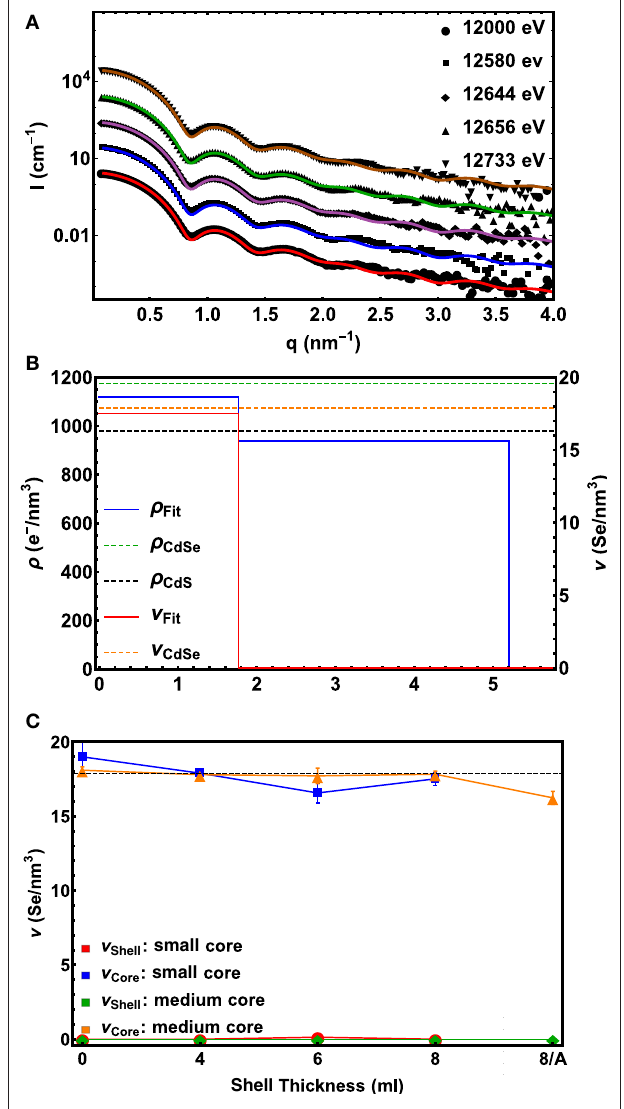
FIGURE 2 | (A) Experimental ASAXS curves (symbols) fitted with a unique spherical core/shell model (lines) for the small core/shell CdSe/CdS NC-sample with the 8 ML CdS shell. The scattering cross section I ( q , E ) plotted over the scattering vector q were recorded at 5 different x-ray energies around the Se-K-edge. The scans are shifted vertically for clarity. The lowest curve is plotted in absolute units, whereas the scattering curves above are each scaled by a factor of 10. (B) The resulting density profile for the sample in (A) s depicted. The Se-density ν (red line) is plotted on the right axis and the total electron density ρ (blue line) on the left axis as a function of the distance from the centre of the sphere. The dashed lines mark the theoretical density values found in bulk materials. (C) The Se-concentration ν in the core and the shell as a function of shell thickness is shown. The dashed lines mark the theoretical values for pure CdSe and CdS, respectively. Note that “0” denotes the initial pure CdSe NC and “8/A” the 8 ML thick shell sample after annealing. For the annealed small core/shell sample we have no ASAXS